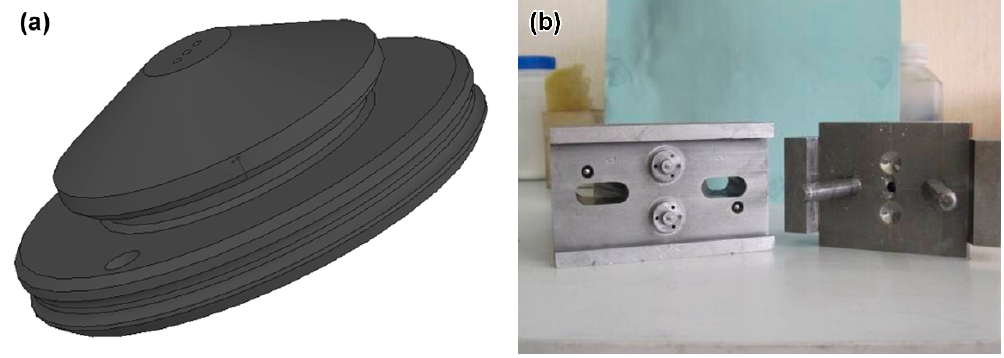
Figure 3. Schematic diagram ( a ) and micro mold ( b ) of ceramic nozzles with multi-micro holes.